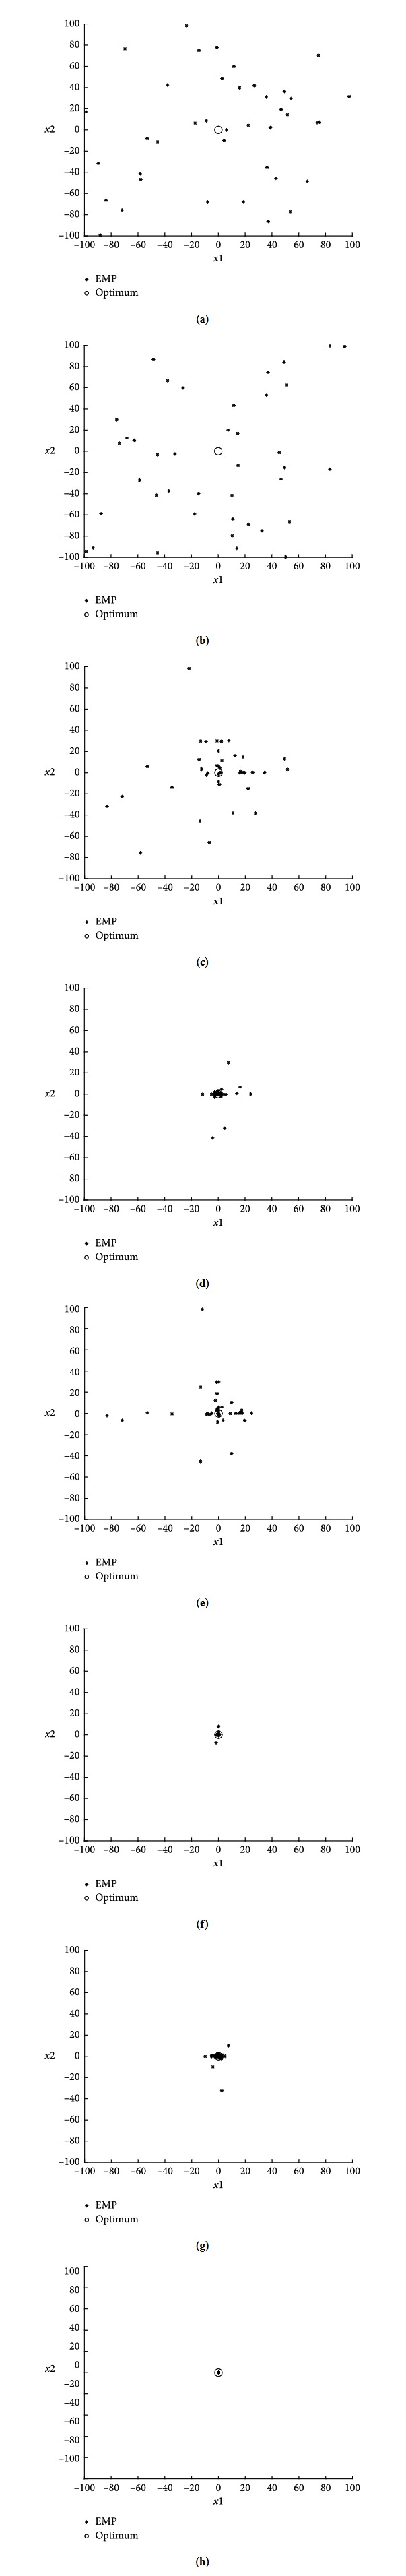
The convergence behavior of EFO and iEFO on Sphere function. (a) Population distribution at iteration = 1 for EFO. (b) Population distribution at iteration = 1 for iEFO. (c) Population distribution at iteration = 10 for EFO. (d) Population distribution at iteration = 10 for iEFO. (e) Population distribution at iteration = 20 for EFO. (f) Population distribution at iteration = 20 for iEFO. (g) Population distribution at iteration = 30 for EFO. (h) Population distribution at iteration = 30 for iEFO.